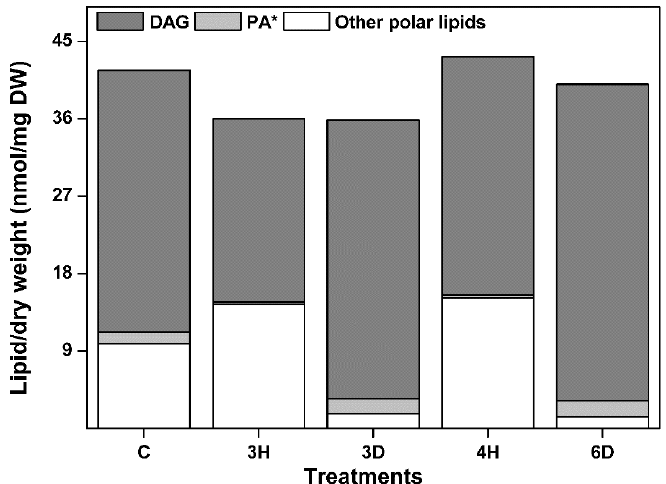
Figure 7. Total glycerolipid content of the A. thaliana seeds during the hydration–dehydration cycles. The treatment was the same as that described in Figure 3. DW, dry weight. * The PA contents were published previously [34].